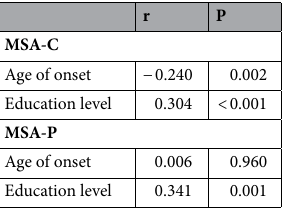
Table 5. Spearman correlation between age of onset and education level and